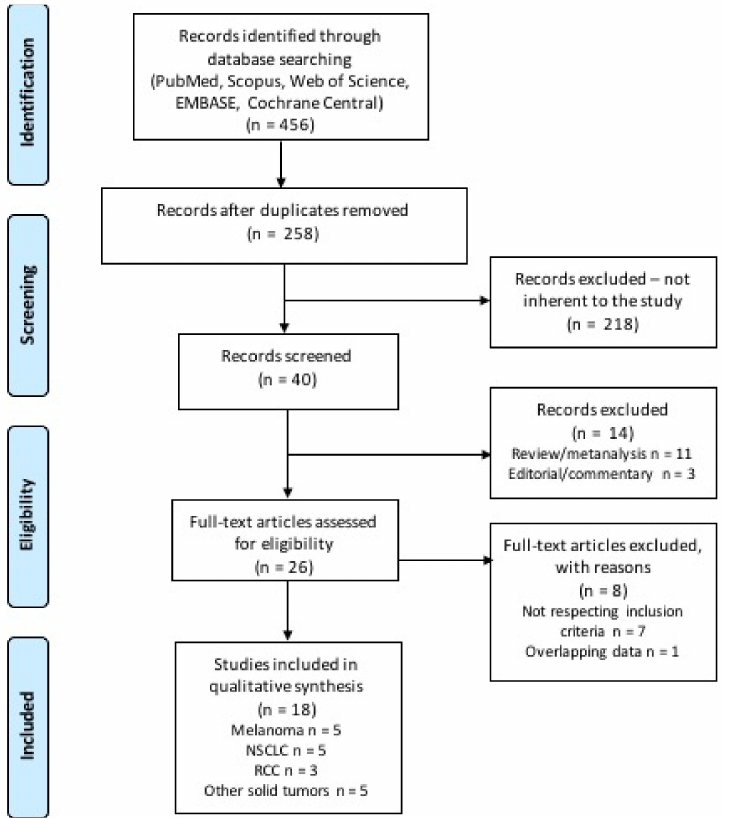
Figure 2. Flow diagram of literature research and study